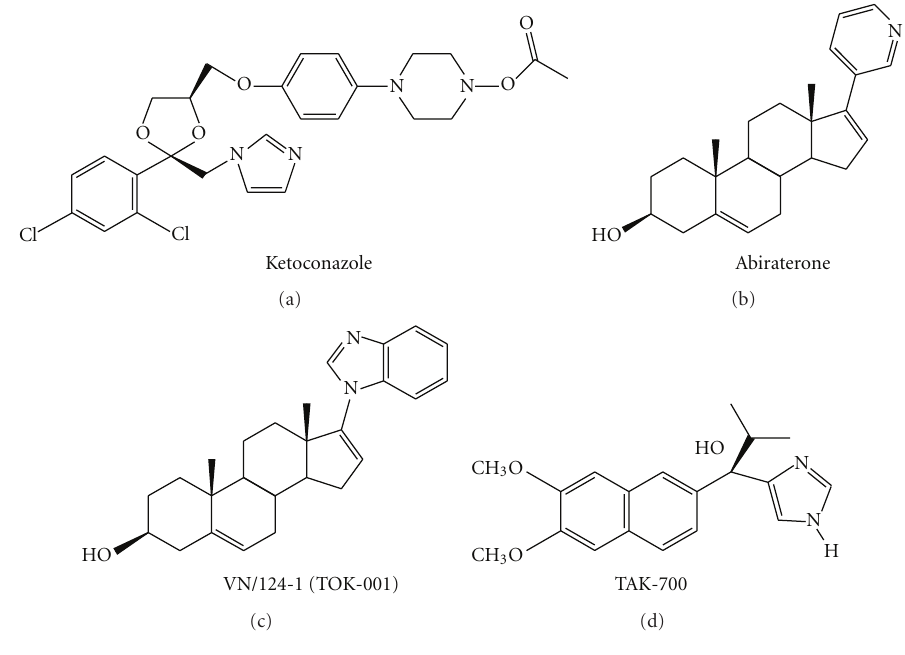
Figure 3: Structures of Inhibitors of